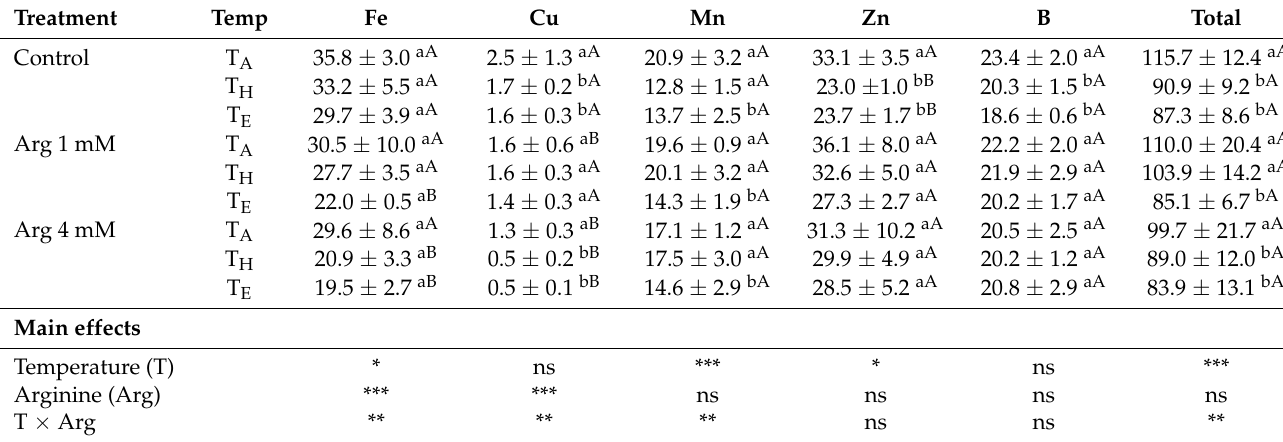
Table 4. Content of microelements (mg kg − 1 DW) of cauliflower florets affected by short-term heat stress and foliar arginine